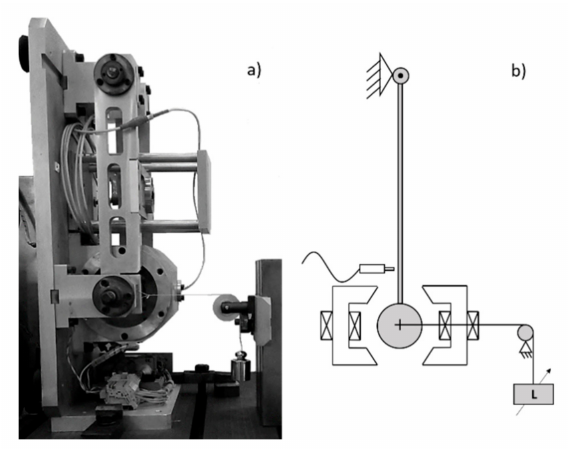
Figure 6. Experimental setup for the load variation estimation test. Picture ( a ) and layout ( b ) of the setup. L : variable